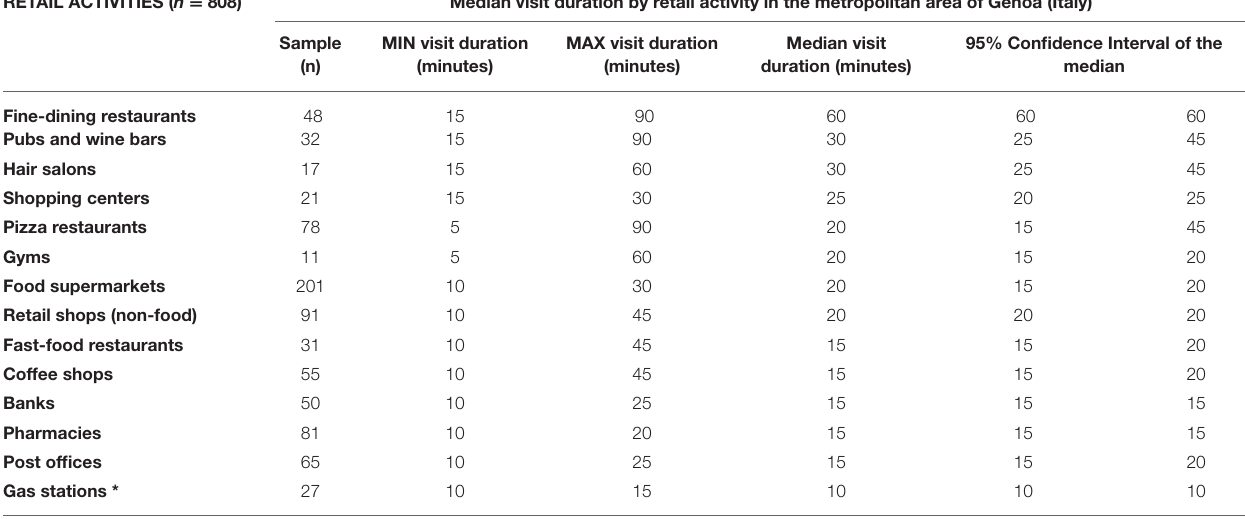
TABLE 1 | Estimated parameter: median visit duration by retail activities. RETAIL ACTIVITIES ( n =